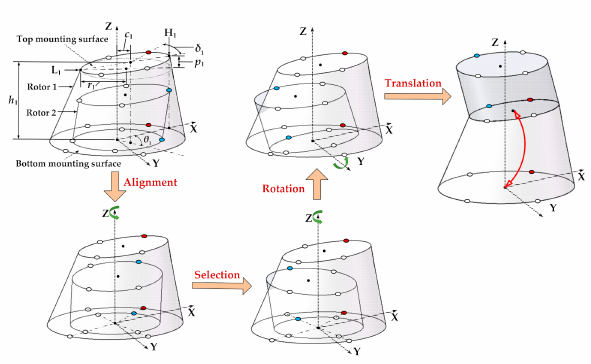
Figure 2. The assembly processes of a two-stage simulated